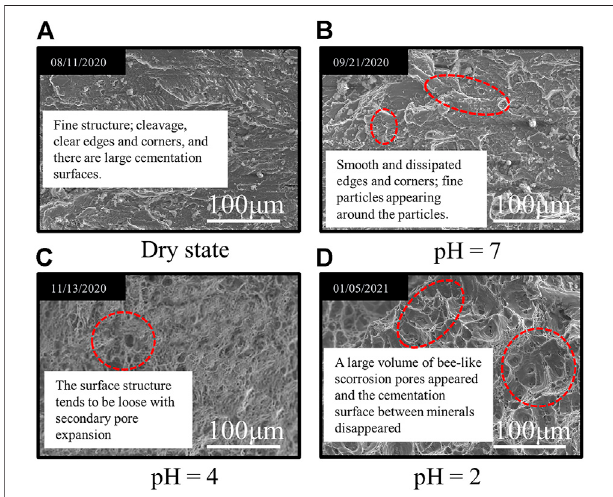
FIGURE 3 | Apparent scanning electron microscopy images of granite under different solution conditions for 49 days. (A) Dry state. (B) pH=7. (C) pH=4. (D)